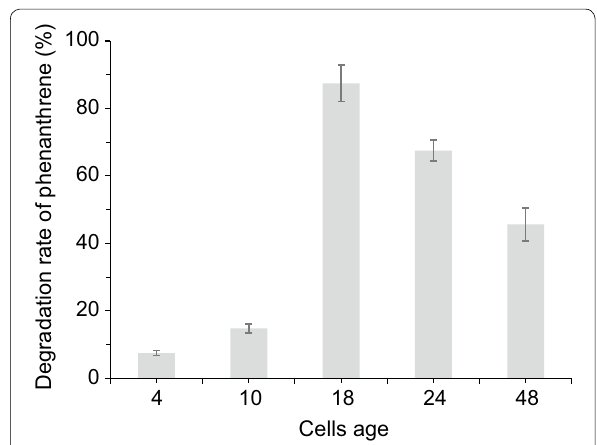
Fig. 2 Effect of cells age on biodegradation of phenanthrene. S. polyaromaticivorans was inoculated into 30 LB medium in a 150-mL flask and cultured at 30 °C and 160 rpm. Cells were collected after 4, 10, 18, 24, and 48 h of culture, respectively, and then inoculated in CPS to degrade phenanthrene for 5